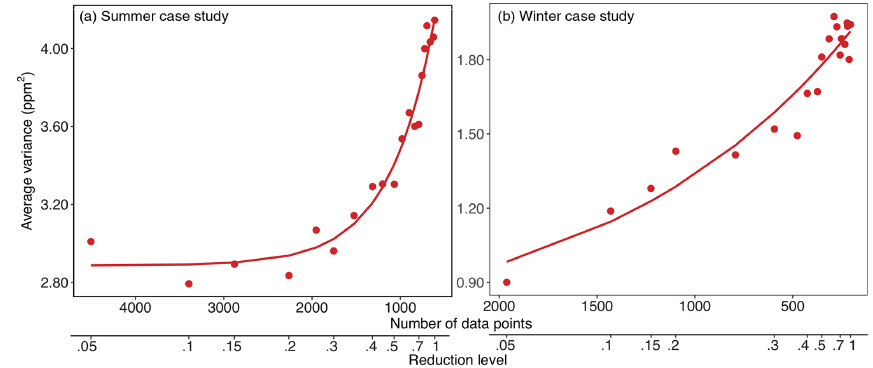
Figure 6. The amount of variance in the data that is lost through the process of data reduction for the summer (a) and winter (b) case studies. These plots provide a metric to help decide on an appropriate level of reduction and do not require costly runs of the inverse model to be